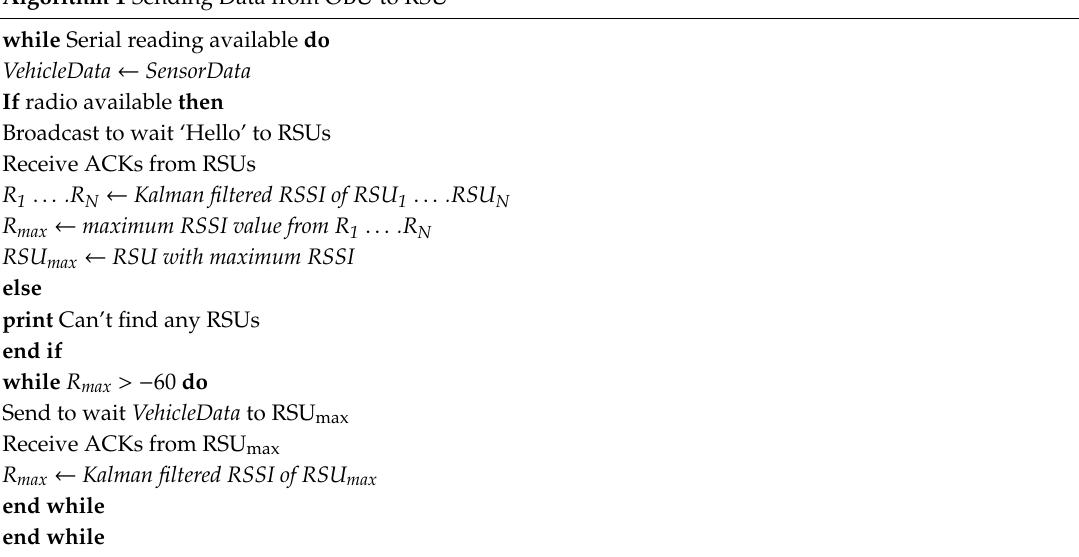
Algorithm 1 Sending Data from OBU to